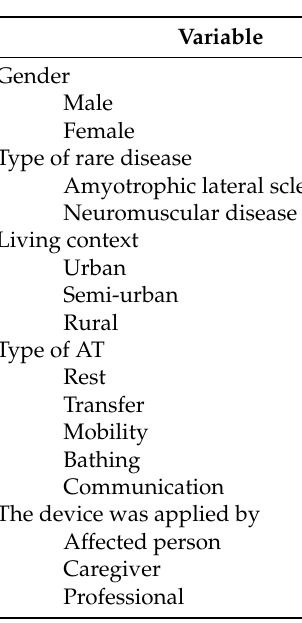
Table 1. Characteristics of